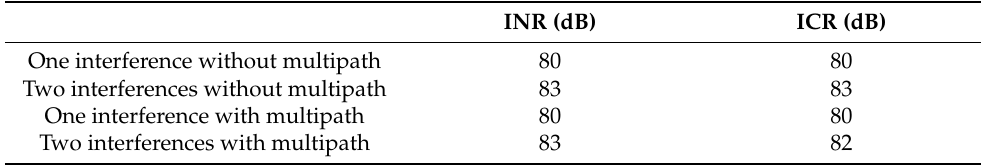
Table 5. ICR with STAP in different condition.